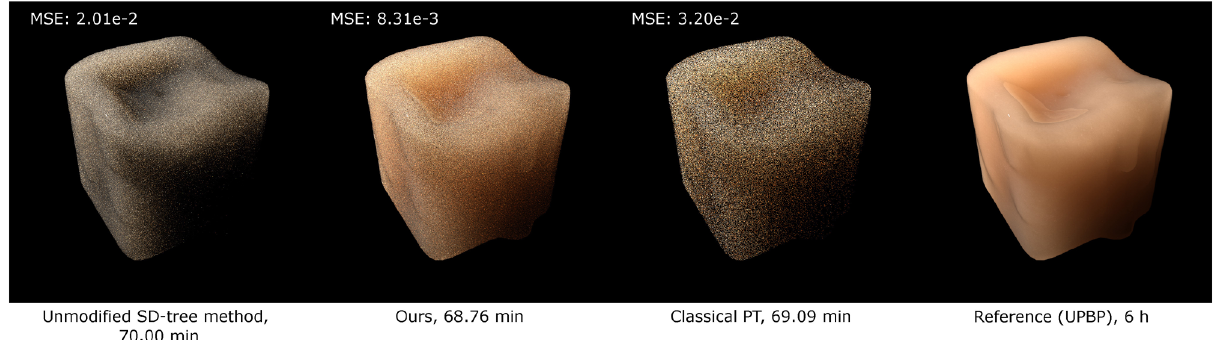
Fig. 2 Comparison of SD-tree path guiding and our method, with equal time, on the Candle scene. The SD-tree method has difficulty in finding paths to the light source and produces a darker image.